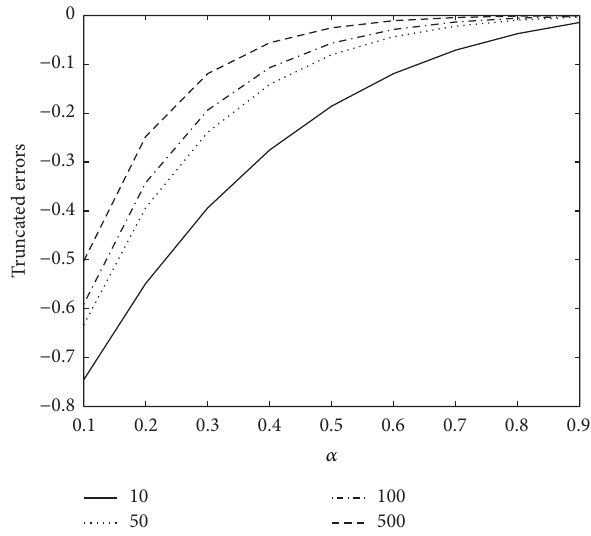
Figure 1: Truncated errors of truncated G-L formula with support lengths 10 , 50 , 100 , and 500 and fractional orders 𝛼 from 0.1 to 0.9 . (𝛼 1 ) > 𝜔 (𝛼 2 ) 𝑘 ≥ 1 , 𝛼 > 𝛼 0 < 𝛼 < 1 , and If 0 > 𝜔 1 2 , 1 𝑘 𝑘 , for < 1 0 < 𝛼 2